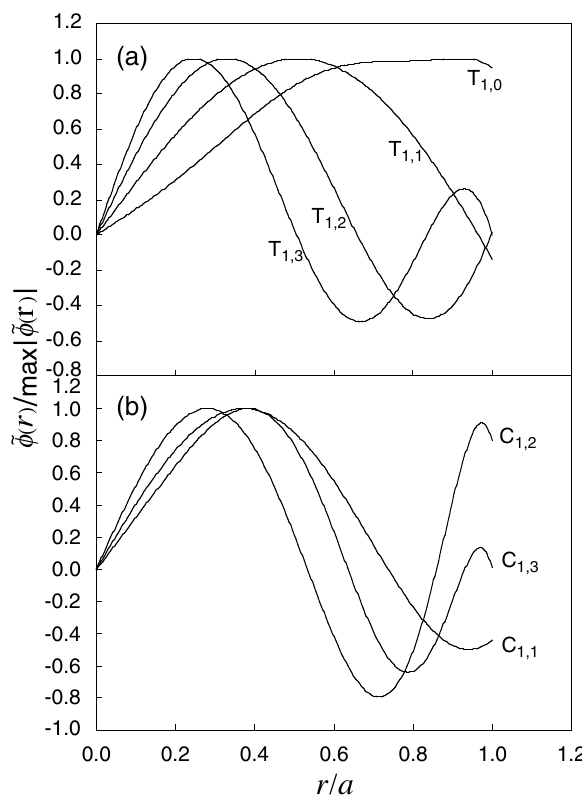
FIG. 6. Examples of the approximate radial mode structure as a function of r=a for the two classes of dipole modes: (a) the , and the T , T , T modes; (b) the usual dipole mode T 1 ; 0 1 ; 1 1 ; 2 1 ; 3 high-frequency coupling modes. The case considered here is , and zero wall imped- for ak (cid:3) 2 : 0 , b=a (cid:3) 1 : 5 , (cid:10) (cid:3) 0 : 697 (cid:10) o ance. The maximal amplitude is normalized to cases of k (cid:3) 0 and ak (cid:3) 2 , respectively. The correspond- (cid:2)j is shown in Figs. 9 and 10. Also shown in ing j Im (cid:1) (cid:13) =(cid:10) o (cid:2)j of the T mode for the wall Fig. 10 is the j Im (cid:1) (cid:13) =(cid:10) o 1 ; 0 impedance of Z (cid:3) 0 : 2 . Figure 11 displays the detail of the real part of (cid:13) 2 =(cid:10) 2 as a function of (cid:10)=(cid:10) in the high- o o intensity region for the case of ak (cid:3) 2 : 0 . The approxi- mate radial structures of the modes investigated are given in Fig. 12 where the results were computed by including the coefficients up to A for ak (cid:3) 2 : 0 , (cid:10) (cid:3) 0 : 6976 (cid:10) , and o 3 zero wall impedance.